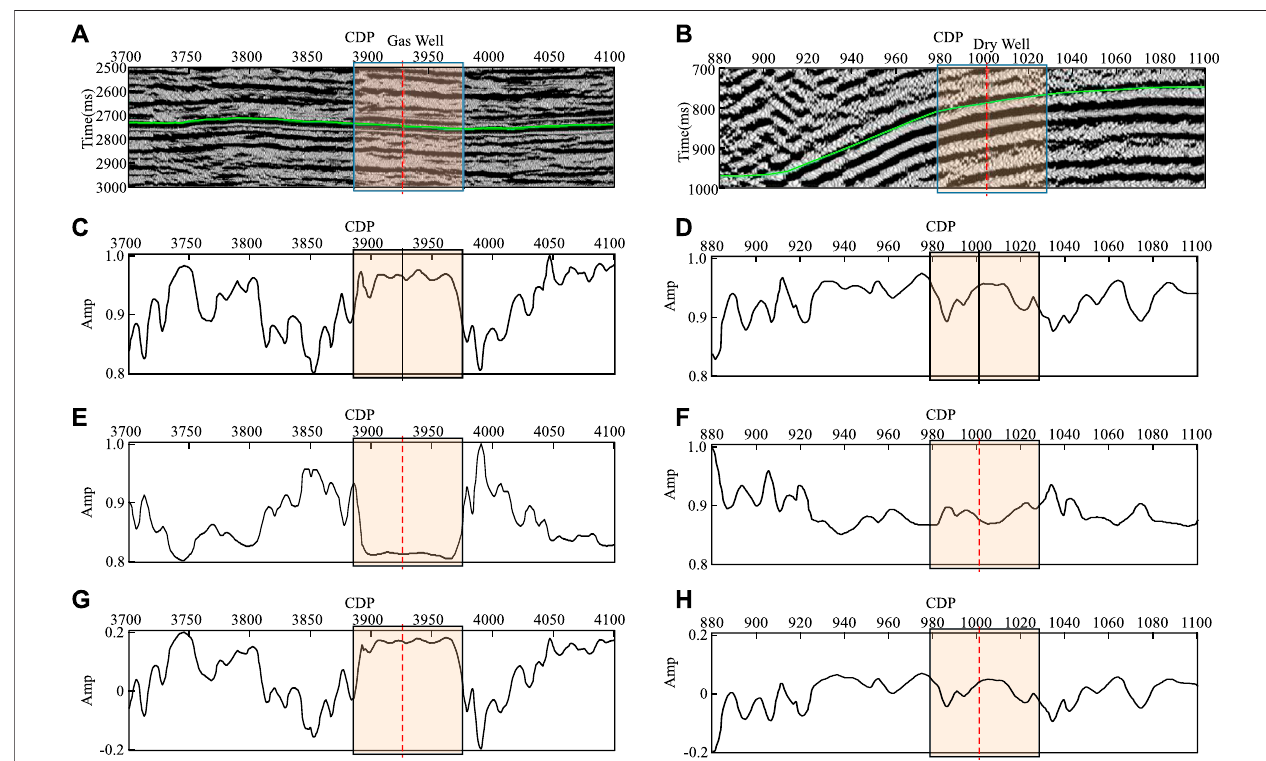
FIGURE 2 | The Seismic-print characteristics of two seismic sections intersecting different wells. (A) The seismic section intersecting the gas well. (B) The seismic section intersecting the dry well. (C) The fi rst-order cepstrum coef fi cient ’ s volume of the seismic section in (A) . (D) The fi rst-order cepstrum coef fi cient ’ s volume of the seismic section in (B) . (E) The second-order cepstrum coef fi cient ’ s volume of the seismic section in (A) . (F) The second-order cepstrum coef fi cient ’ s volume of the seismic section in (B) . (G) The result of the new parameter C 1 − 2 in (A) . (H) The result of the new parameter C 1 − 2 in (B)